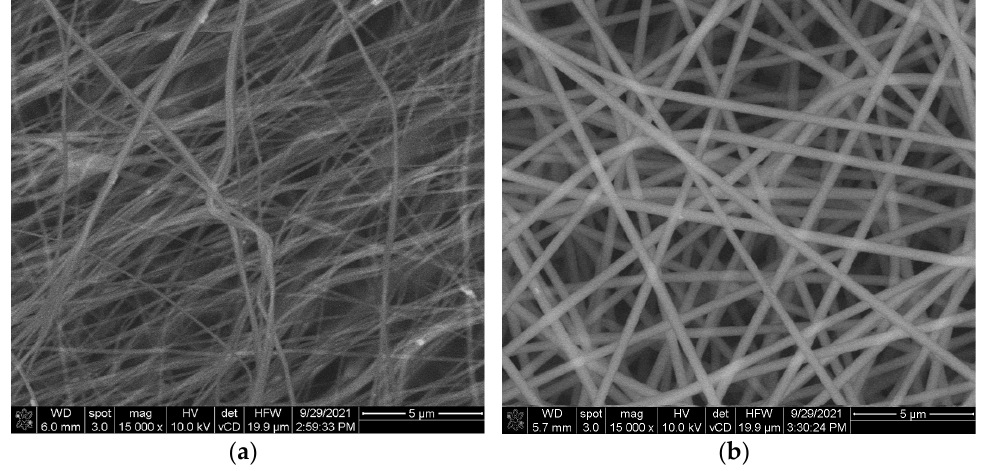
Figure 11. Qualitative comparison of resulting nonwoven media at 15,000× magnification. ( a ) SEM image of filter medium resulting from 6% polyacrylonitrile solution, trial #1. ( b ) SEM image of filter medium resulting from 9% polyacrylonitrile solution, trial #3.